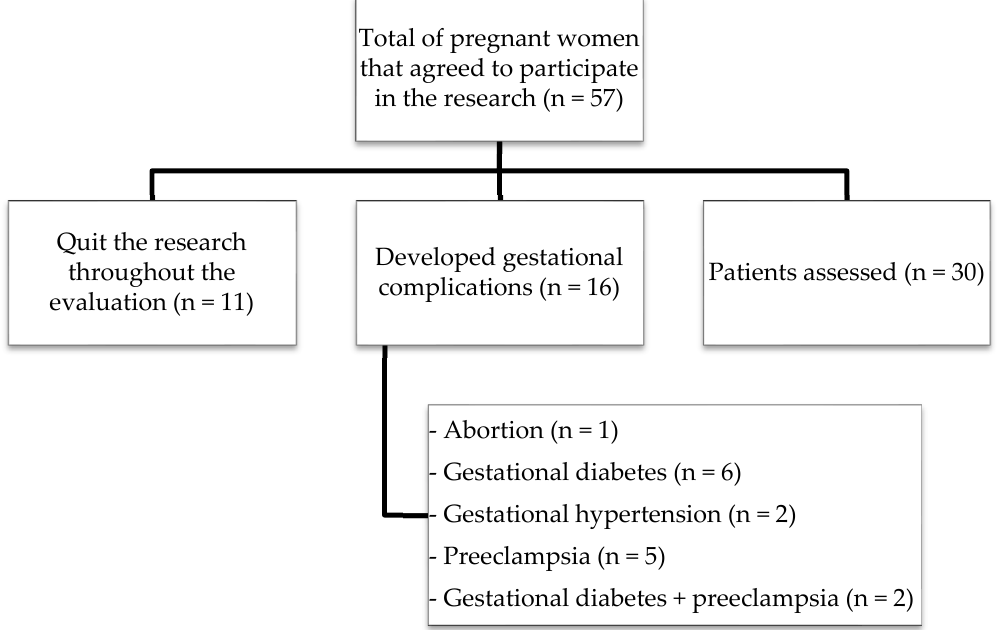
Figure 1. Flowchart of patients included in the study.